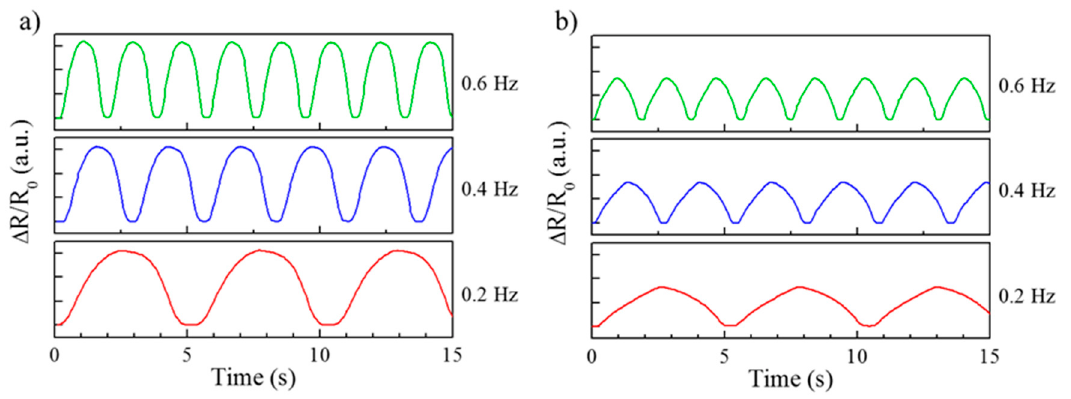
Figure 9. Hysteresis of strain sensors. ( a ) Hysteresis of the longitudinal strain sensor. ( b ) Hysteresis of the lateral strain sensor.